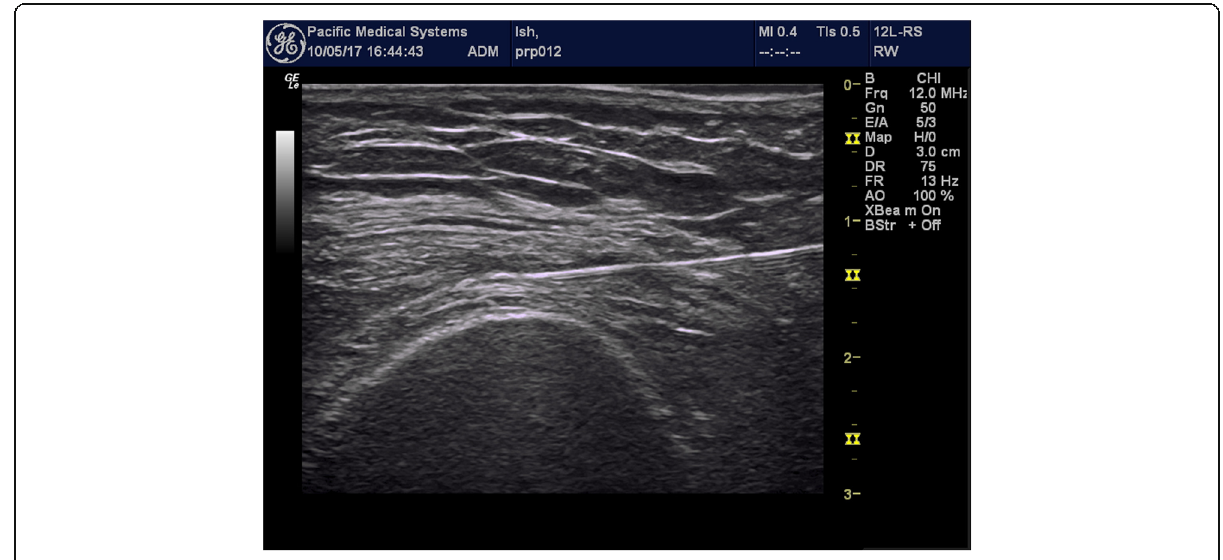
Fig. 2 Suprapetella pouch injection under USG